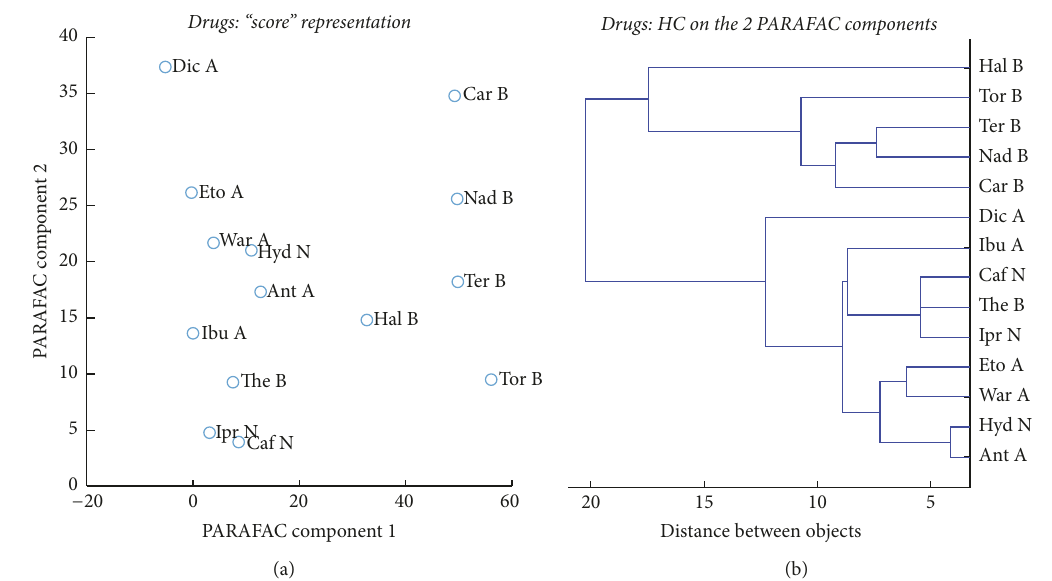
Figure 8: PARAFAC analysis of the drugs: the two columns of matrix 𝐷 used as 𝑥 and 𝑦 coordinates (a) and HC performed on these coordinates